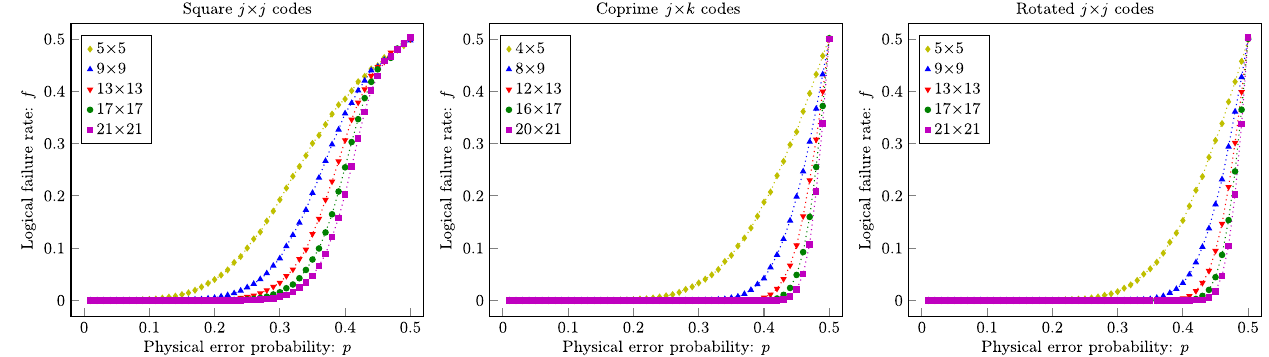
FIG. 11. Logical failure rate f as a function of physical error probability p for surface code families: square, coprime, and rotated, subject to pure Y noise. Data points are sample means over 60 000 runs using exact maximum-likelihood decoding. Dotted lines connect successive data points for a given code size.